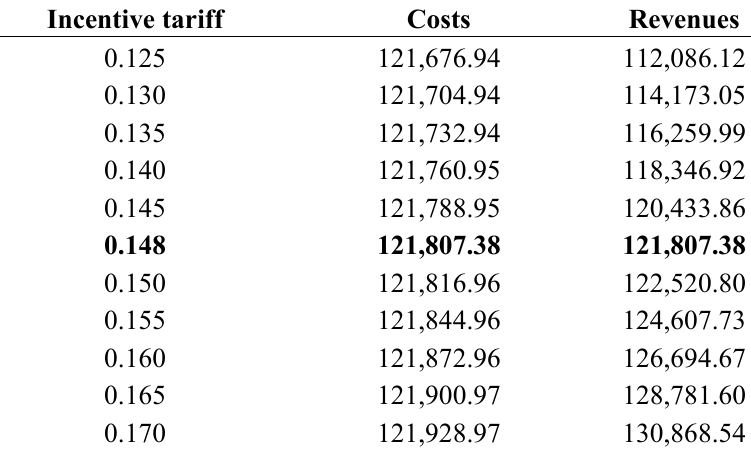
Table 4. Economic results according to incentive tariff (in euros).